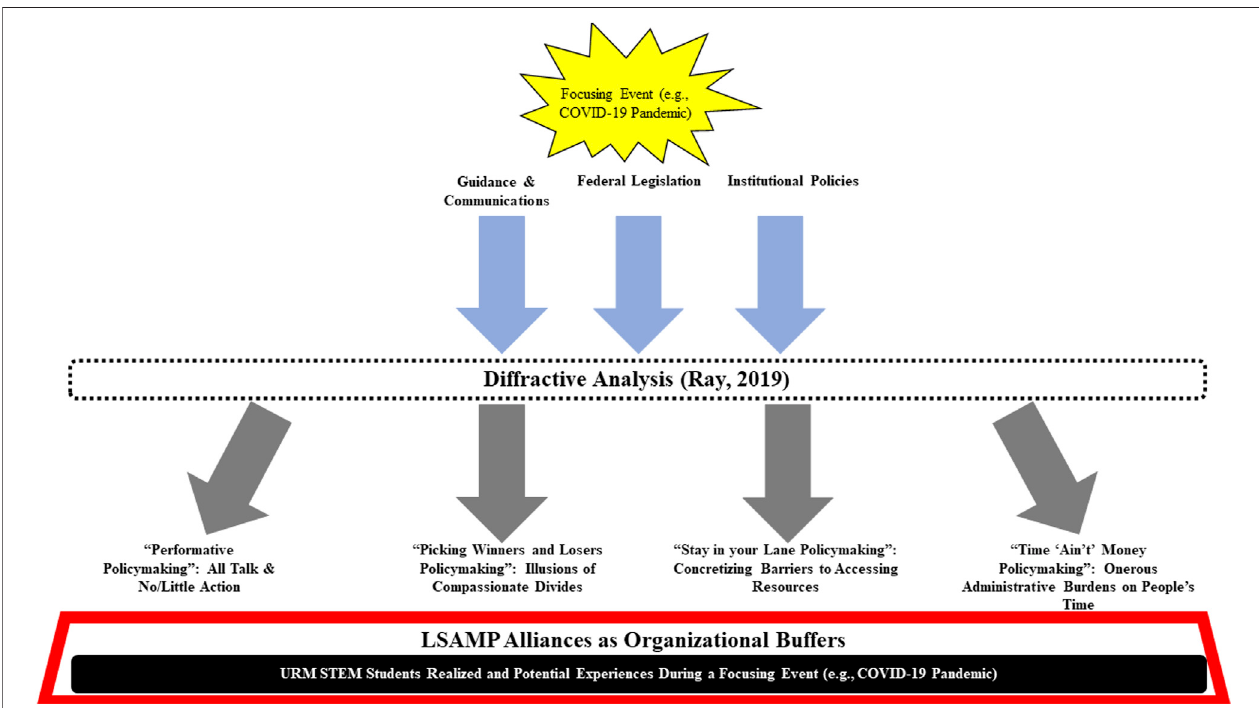
FIGURE 2 | Updated Diagram Re fl ecting the Potential Role of LSAMP as Organizational Buffers During Focusing